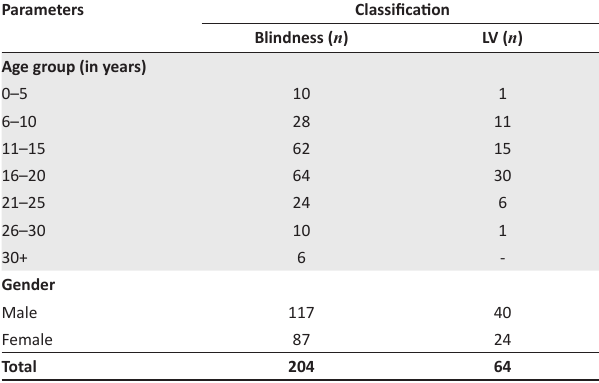
TABLE 2: Prevalence of low vision and blindness.